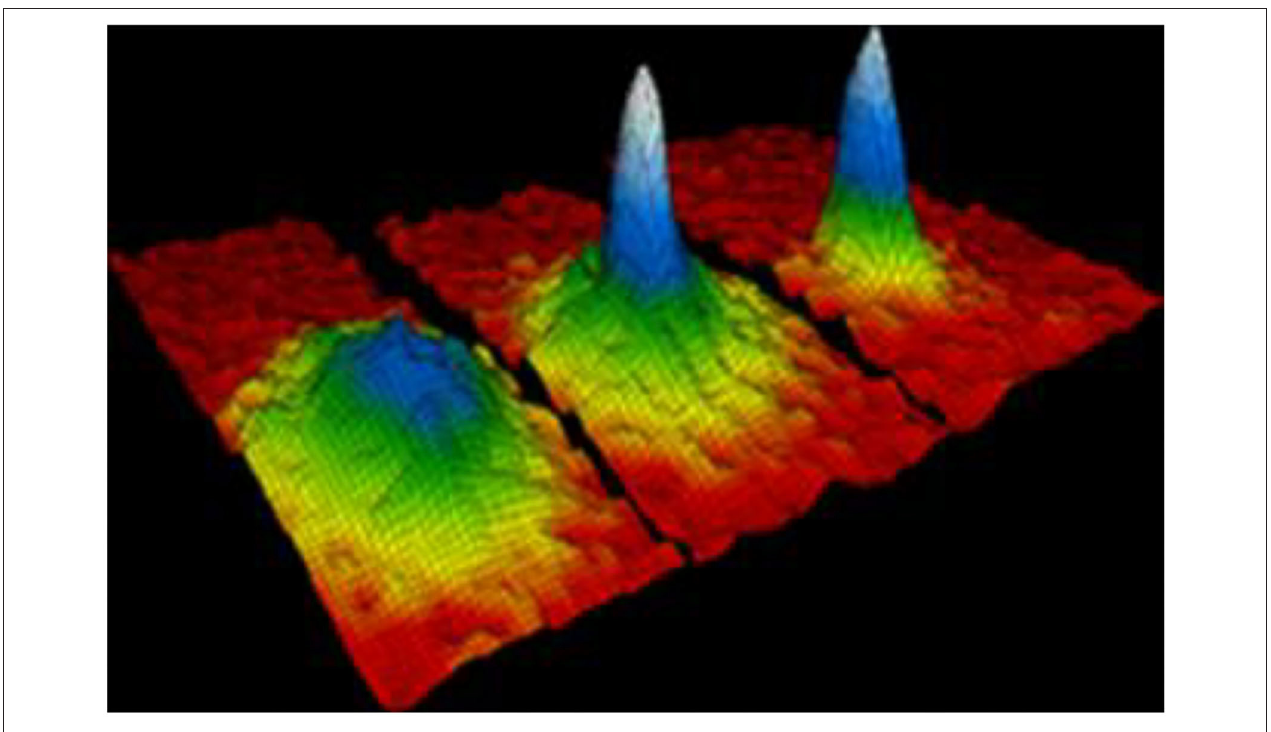
FIGURE 1 | Bose-Einstein Condensate